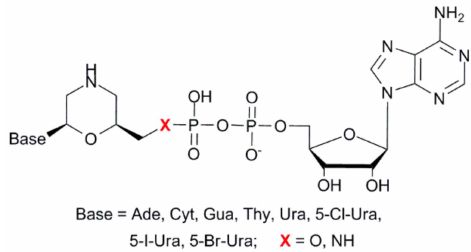
Figure 2. Morpholino nucleoside adenosine dinucleotides